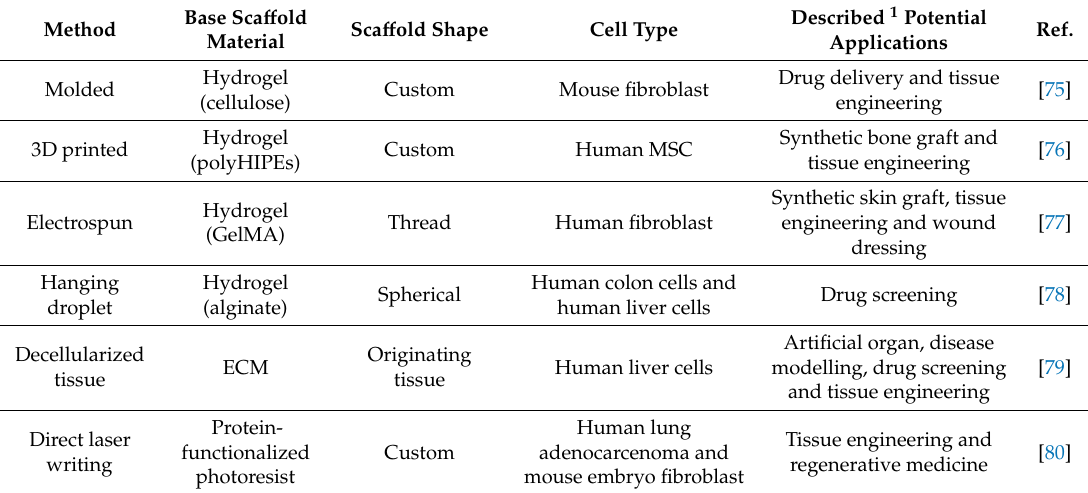
Table 2. Examples of three-dimensional cell culturing methods from recent